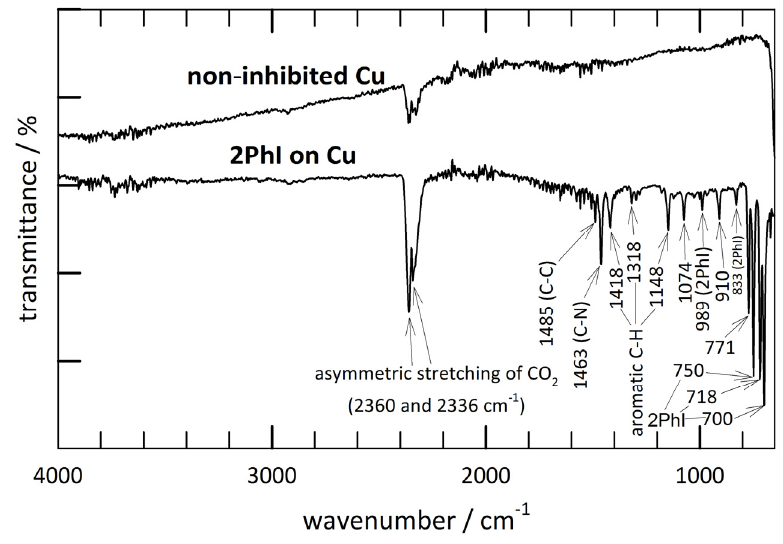
Figure 9. ATR ‐ FTIR spectra of the 2PhI ‐ inhibited and noninhibited [5] copper samples after 1 h of Figure 9. ATR-FTIR spectra of the 2PhI-inhibited and noninhibited [5] copper samples after 1 h of immersion in 3 wt.% NaCl solution. immersion in 3 wt.% NaCl